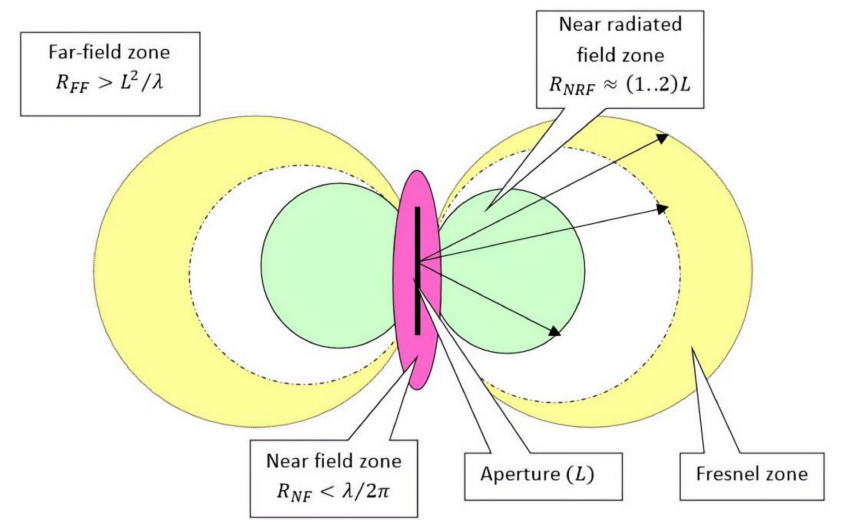
Figure 1. Radiated zones from an electromagnetic radiation source with finite